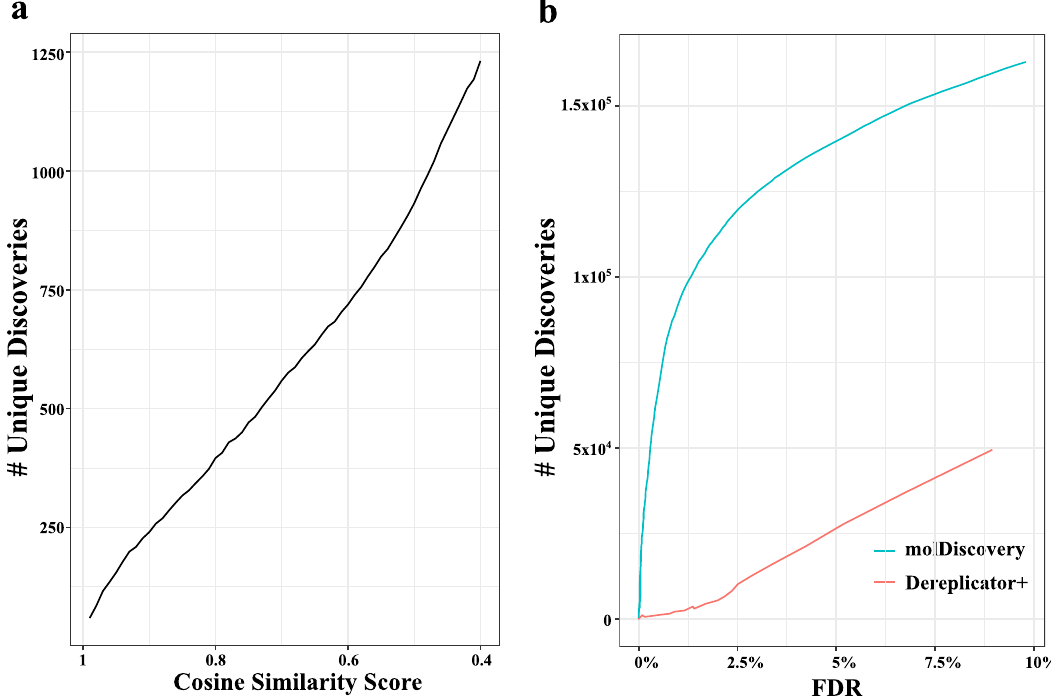
Fig. 5 Number of unique discoveries by spectral library search and in silico database search. a spectral library search against NIST17 and b in silico database search against